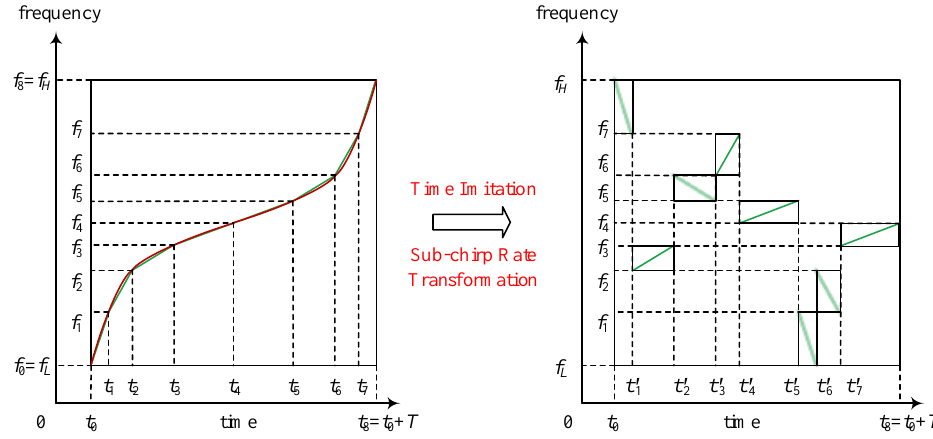
Figure 2. The time-frequency structure of one of M transmit signals of the OFDM-NLFM waveform set.